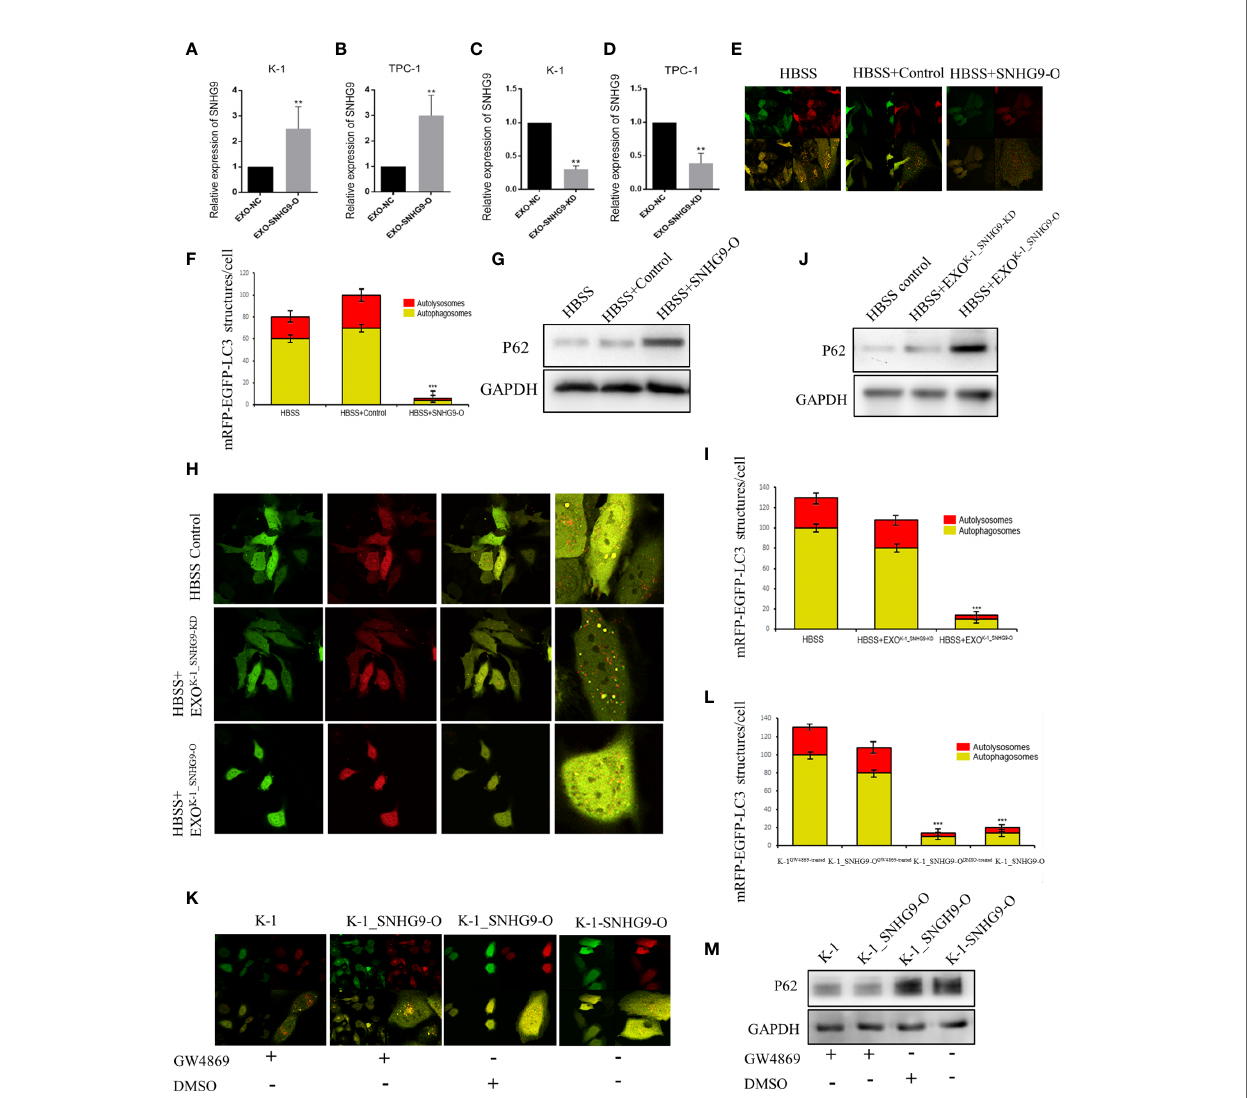
FIGURE 2 | SNHG9 inhibits Nthy-ori-3 cell autophagy through PTC exosomes. (A, B) SNHG9 was signi fi cantly upregulated in K-1 and TPC-1 cell exosomes after overexpressing SNHG9 in PTC cells. (C, D) SNHG9 was signi fi cantly downregulated in K-1 and TPC-1 cell exosomes after knocking down SNHG9 in PTC cells. (E, F) Overexpressing SNHG9 in HBSS treated Nthy-ori-3 cells could inhibit cell autophagy detected by mRFP/mCherry-GFP-LC3B autophagy fl ow. Yellow spots indicate autophagosomes and red spots indicate autophagic lysosomes. (G) Autophagy-related protein P62 was signi fi cantly increased after overexpressing SNHG9 in HBSS treated Nthy-ori-3 cells by Western blot. (H and I) K-1 SNHG9-O/ K-1 SNHG9-KD exosomes could inhibit/promote Nthy-ori-3 cells autophagy detected by mRFP/ mCherry-GFP-LC3B autophagy fl ow. Yellow spots indicate autophagosomes and red spots indicate autophagic lysosomes. (J) P62 was signi fi cantly increased in K- 1 SNHG9-O exosome treated Nthy-ori-3 and was downregulated in K-1 SNHG9-KD exosome treated Nthy-ori-3 cells by Western blotting. (K, L) The impact of K-1 SNHG9-O/ K-1 SNHG9-KD exosomes on Nthy-ori-3 cell autophagy was decreased after K-1 cell exosomes secretion was inhibited by GW4869. (M) P62 protein change after K-1 cell exosomes secretion was inhibited by GW4869. ***P < 0.001, **P < 0.01, data were pooled from three independent experiments. PTC, papillary thyroid cancer; KD, knock down; O, overexpression. HBSS, Hank ’ s balanced salt